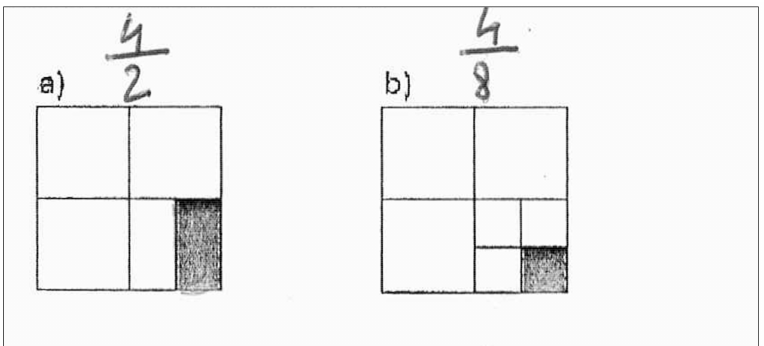
Figure 9. Incorrect solution